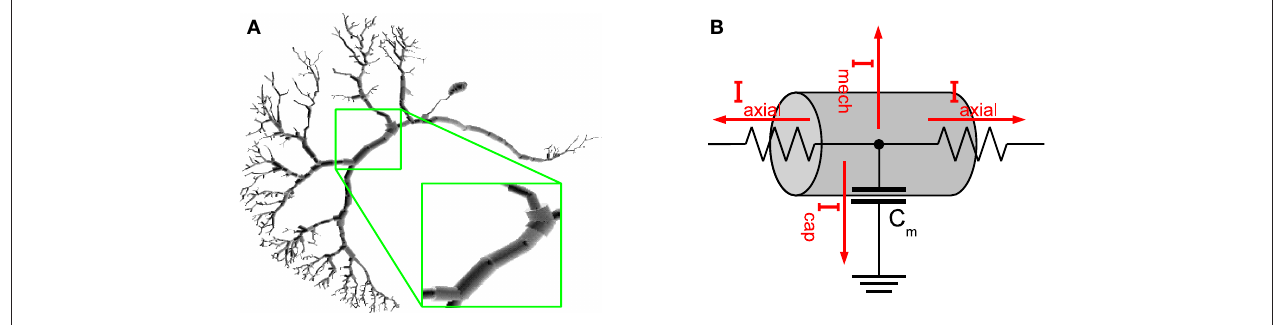
FIGURE 2 | (A) Compartmental model of a VS1 cell from the blowfl y’s visual system. The magnifi cation inset emphasizes how cylinders are used to model the cell. (B) Example of an electric equivalent circuit used to simulate a compartment. The circuit in the picture is the one used by NEURON.